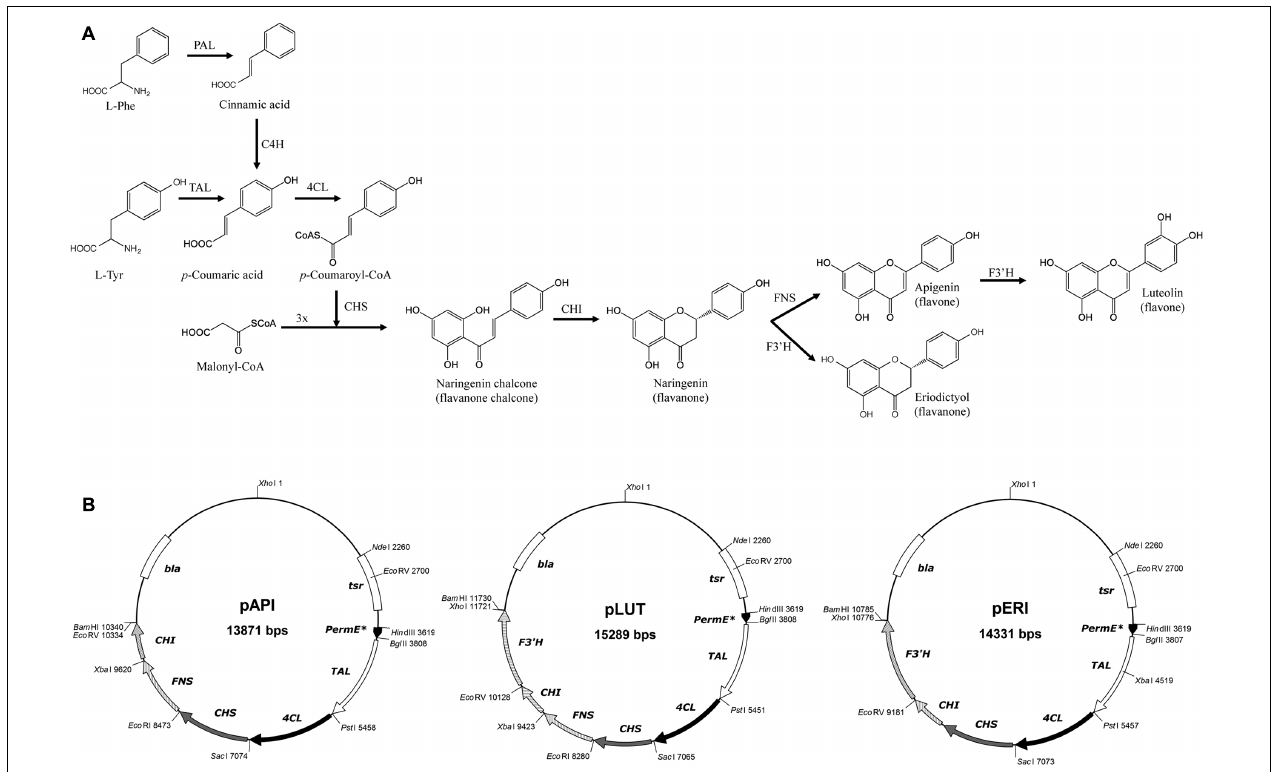
FIGURE 1 | (A) Biosynthetic pathway for biosynthesis of the flavones apigenin and luteolin and the flavanone eriodictyol in plants (using PAL and C4H) and in Streptomyces albus (suing TAL). (B) Recombinant plasmids constructed in this work for the heterologous biosynthesis of these